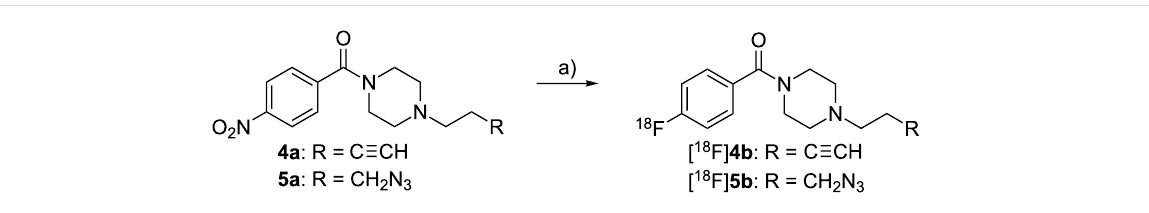
Scheme 4: Preparation of the radiolabeling building blocks [ 18 F] 4b and [ 18 F] 5b . Reagents and conditions: a) K[ 18 F]F, Kryptofix K 2.2.2, DMSO, 150 °C, 60